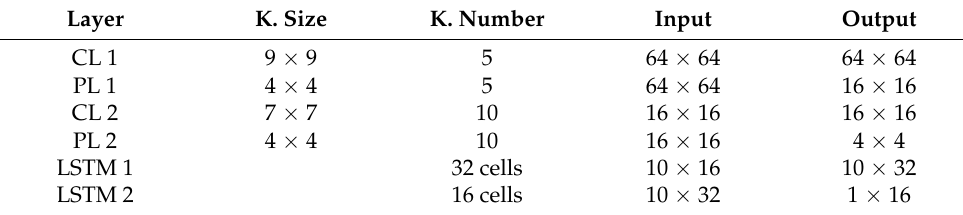
Table 2. Feature map architecture with a shallow receptive field and LSTM cells (A2).